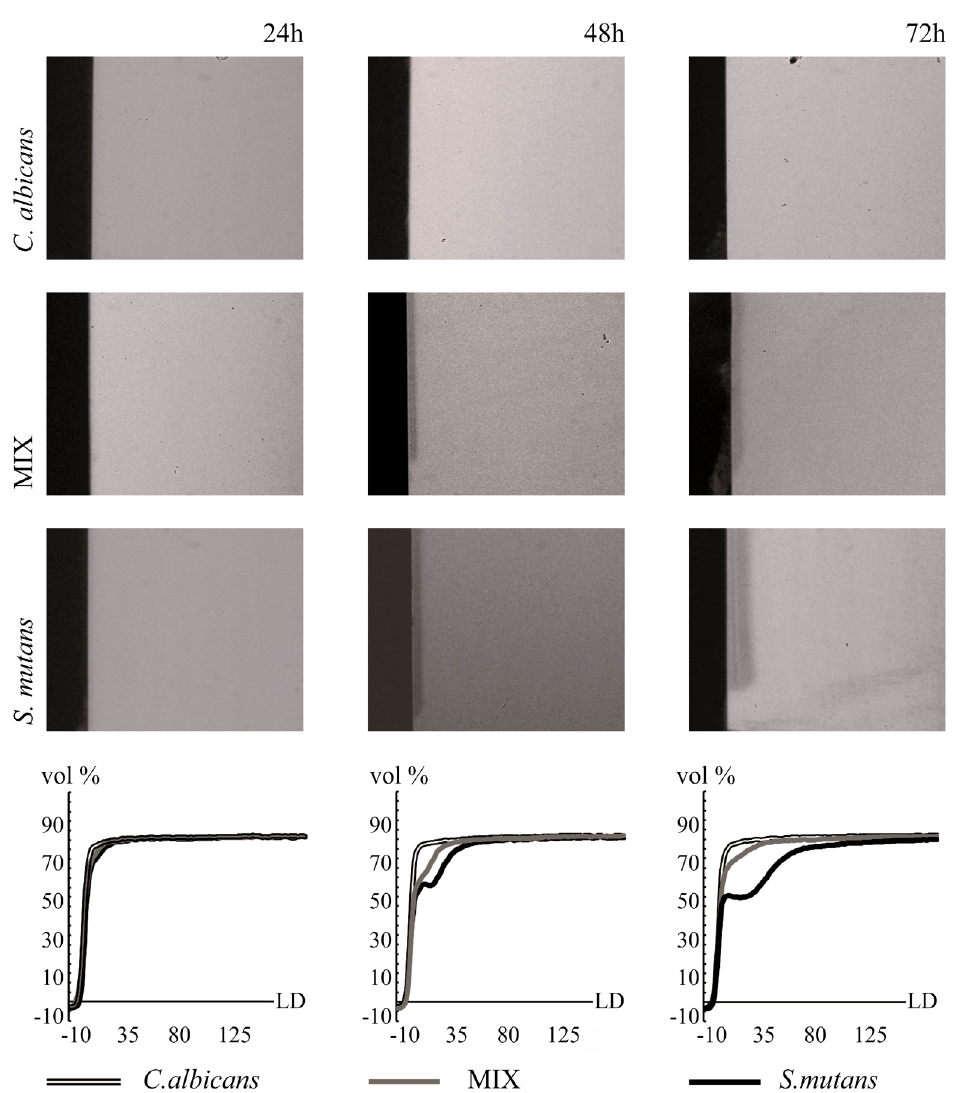
Figure 1- Representative microradiographs and mineral profile after 24, 48 and 72 hours of biofilm growth. Different coloured lines represent mean values of the percentage of mineral volume (vol %) according to lesion depth (LD) for each biofilm microbial